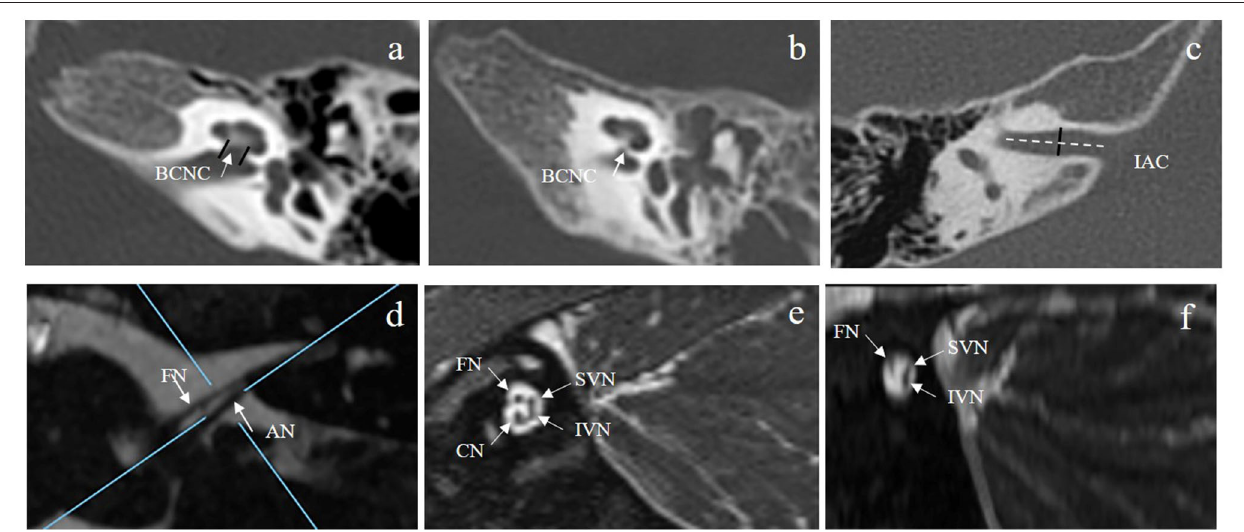
FIGURE 1 | (A,B) show the normal BCNC at the mid-modiolar level on the axial plane of HRCT (A) (two short black lines and white arrow) and a case of BCNC stenosis (B) . (C) shows the IAC diameter measured at the middle of the IAC on the axial plane of HRCT (short black line). (D) shows the vestibulocochlear nerve and the facial nerve at the cerebellopontine angle on the axial plane of MRI. The blue lines illustrate the plane prescribed for oblique plane sagittal images obtained perpendicular to the nerves of the IAC. (E) shows the cochlear, facial, superior vestibular, and inferior vestibular nerves on a reconstructed image in a patient with a normal cochlear nerve. (F) shows that the cochlear nerve could not be observed for one participant with cochlear nerve aplasia. BCNC, bone cochlear nerve canal; HRCT, high-resolution computed tomography; IAC, inner auditory